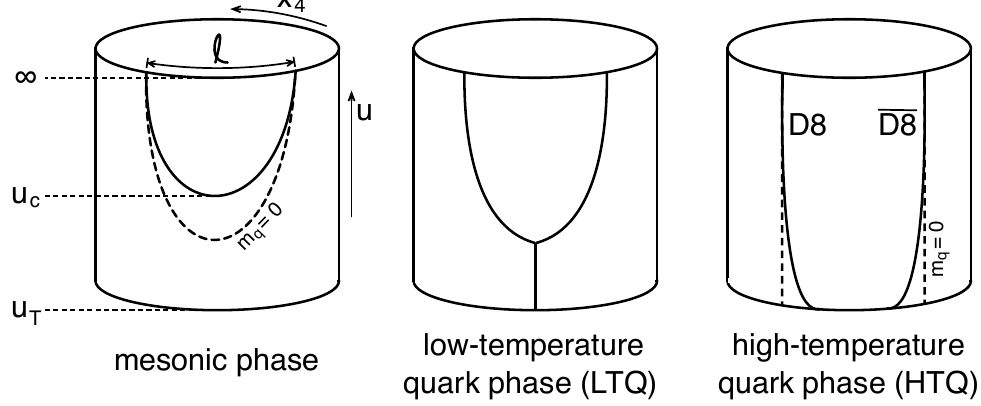
Figure 1 . Schematic view of the di(cid:11)erent embeddings of the (cid:13)avor branes in the background geometry, here represented by the subspace spanned by x 4 and u . The asymptotic distance of the (cid:13)avor branes is given by the dimensionless parameter ‘ (such that the x 4 radius is 1 and ‘ = (cid:25) corresponds to an antipodal embedding). In the mesonic and LTQ phases the (cid:13)avor branes connect above the horizon u T at a point that we denote by u c and which has to be determined dynamically. The mesonic phase has a smooth embedding and vanishing baryon number. In the LTQ phase, which has nonzero baryon number, there is a cusp at which strings are attached, here represented by a straight line. In the HTQ phase, which also has nonzero baryon number, the (cid:13)avor branes extend all the way to the horizon. The dashed lines indicate the massless limit m q = 0 in which there is no stable string con(cid:12)guration and in which the stable phase with nonzero baryon number has straight, disconnected (cid:13)avor